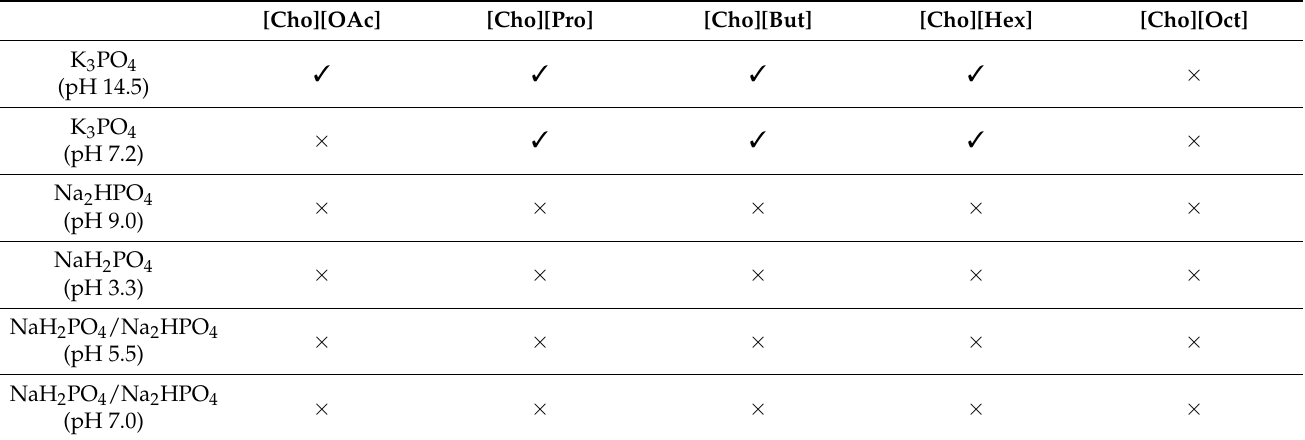
Table 1. Aqueous biphasic systems (ABS) formation by choline alkanoate ionic liquids (ILs) and different phosphate solutions 1 .